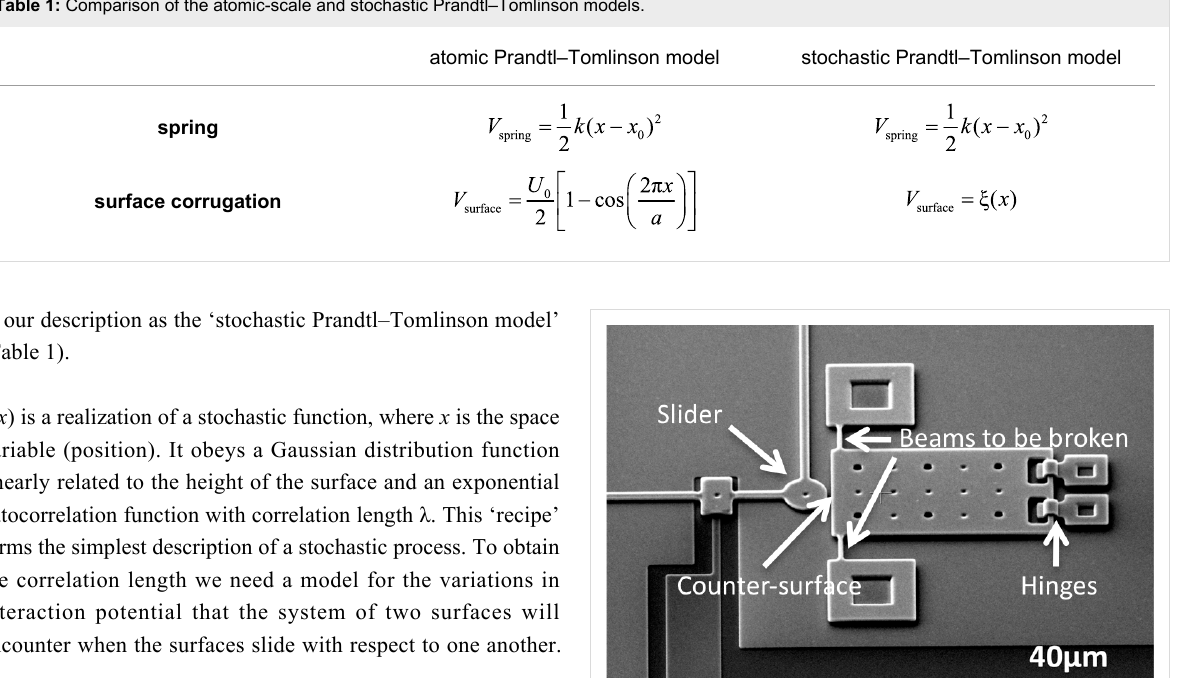
The AFM data show several striking features: first of all, the polycrystalline silicon MEMS sidewall surfaces coming